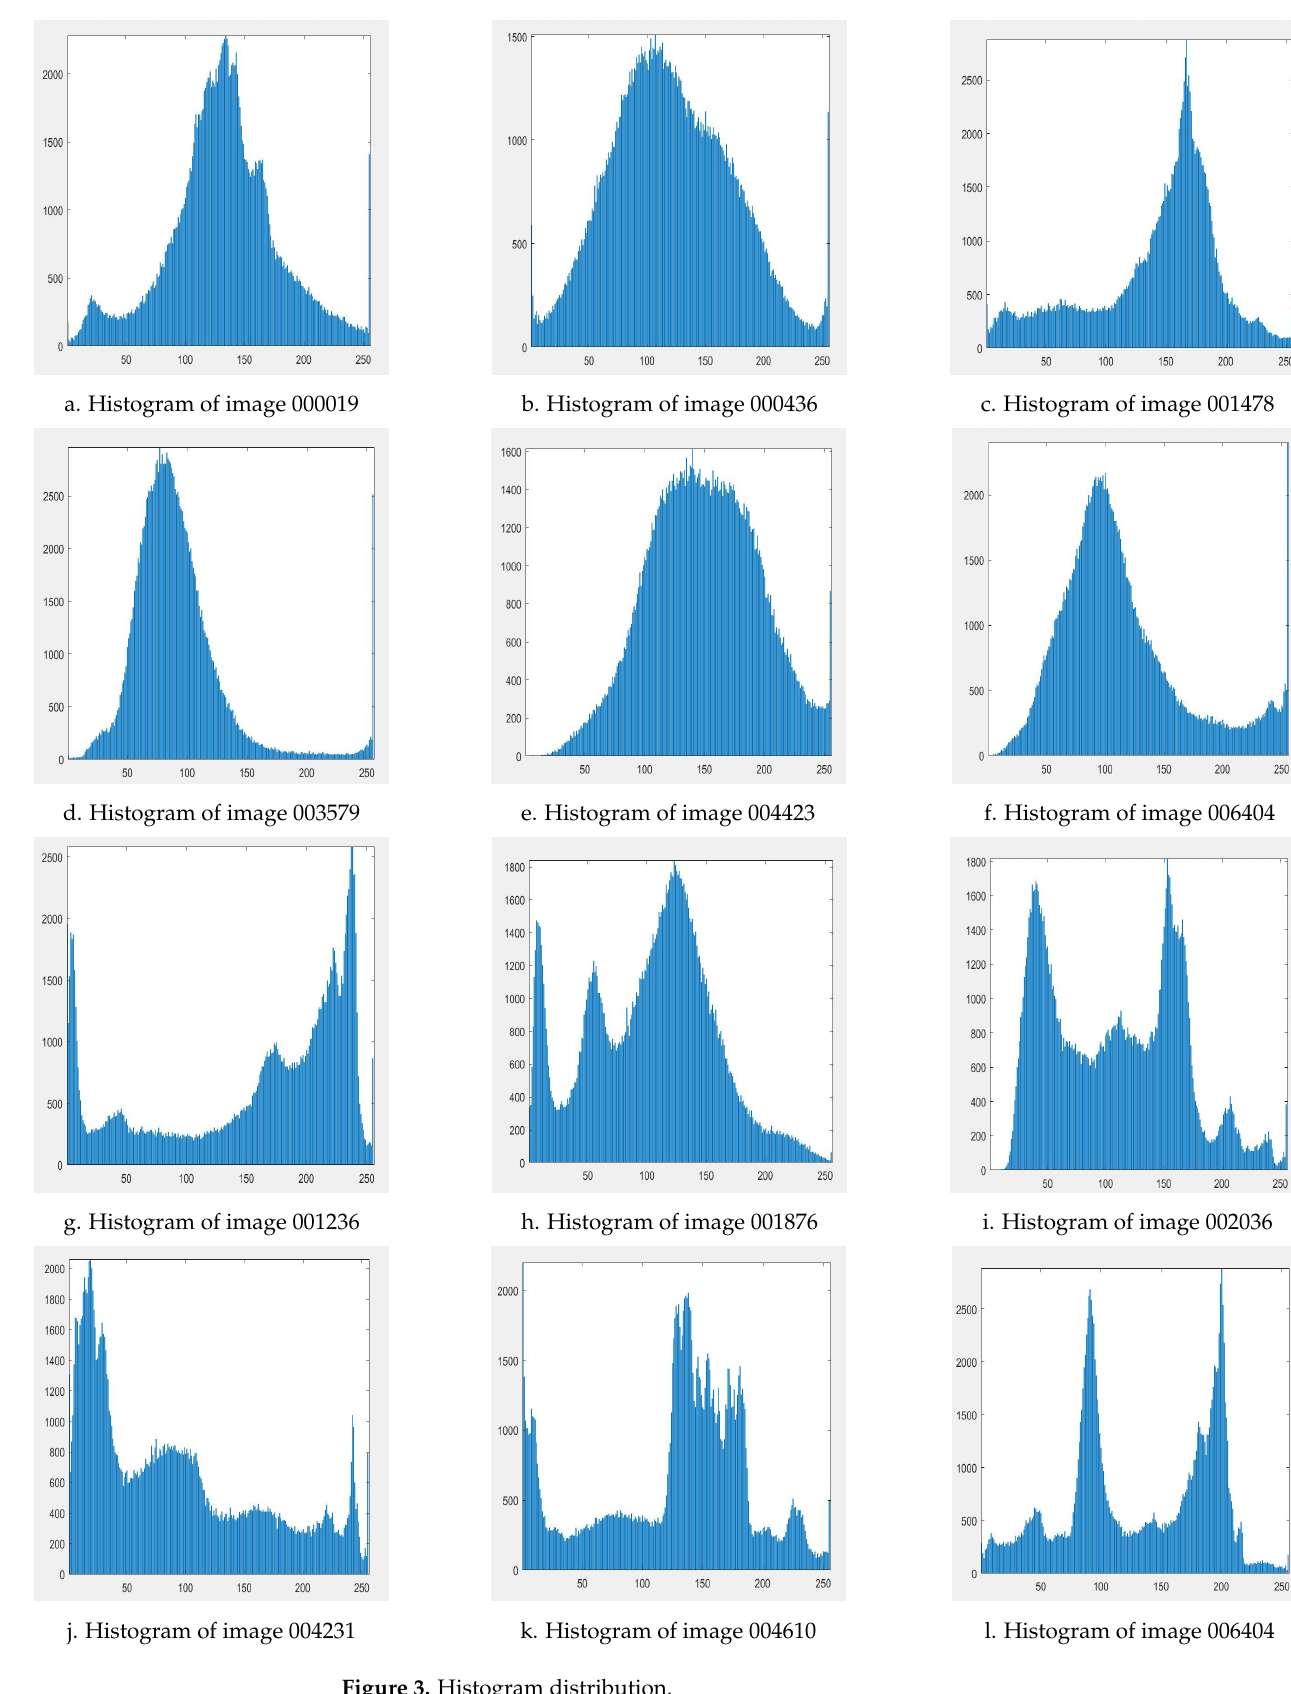
Figure 3. Histogram